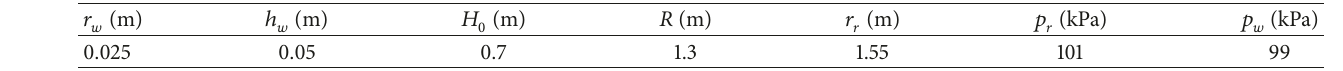
Table 2: Specific parameters in experiment.